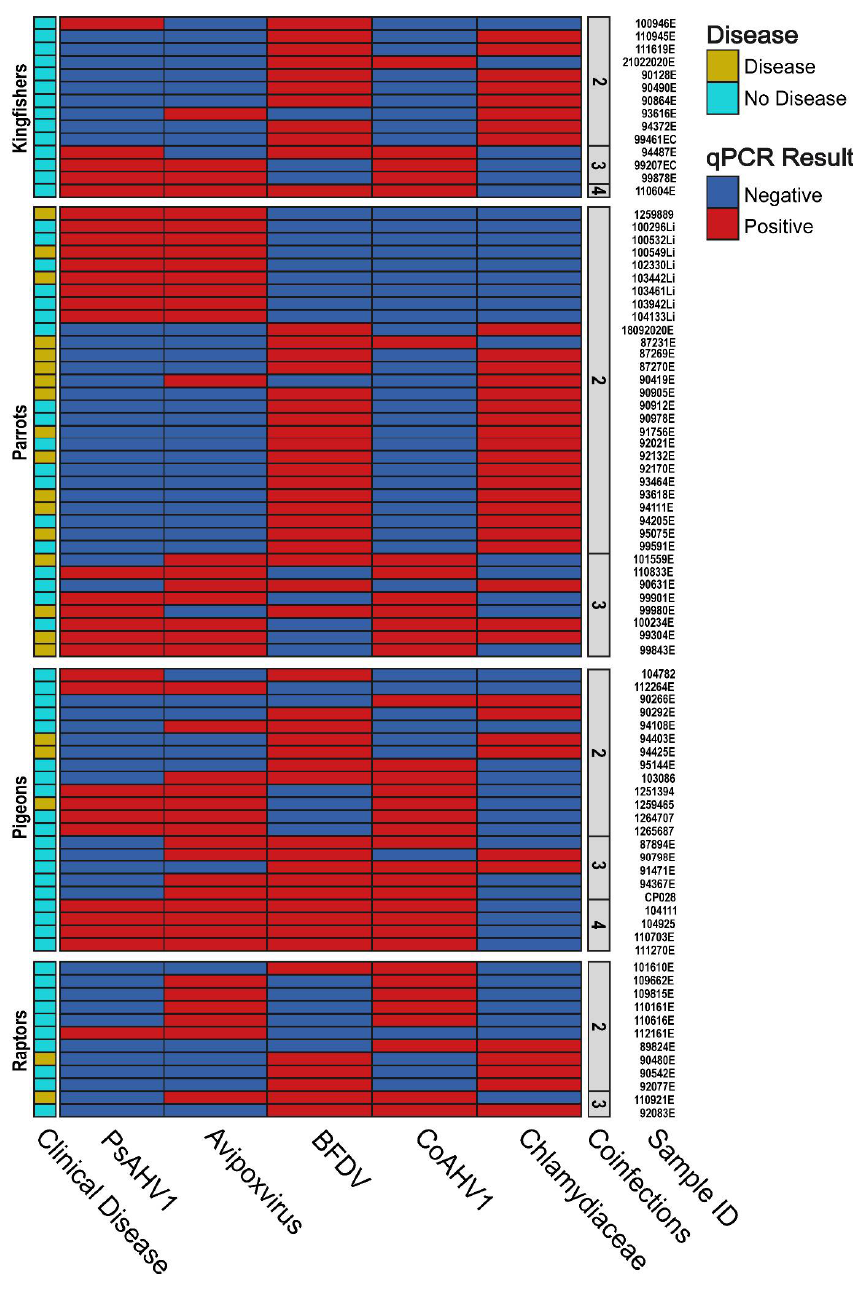
Figure 3. A heatmap showing the coinfections of two, three and four pathogens based on the qPCR results obtained from sampled birds in this study and whether clinical disease is present or absent. Birds are separated by avian category, with sequence identifications and number of coinfections provided along the y